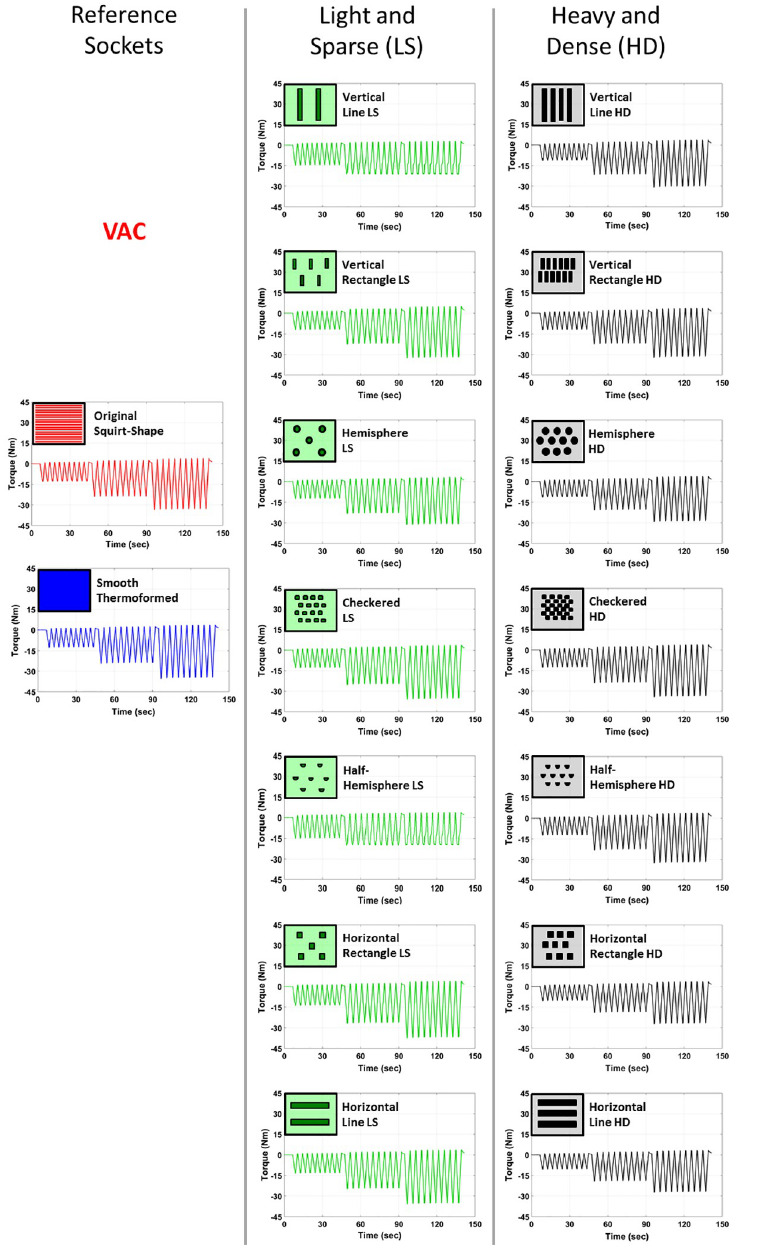
Fig 6. Mean torque for active vacuum with pump at 20 inHg (67.73 kPa) (VAC). also a statistically significant (p < 0.0005) simple two-way interaction between suspension and rotation angle for all texture types, and a statistically significant (p < 0.0005) simple-simple main effect of suspension on all measured torques for all rotation angles. More detailed statisti- cal results are summarized in the S1 Appendix.